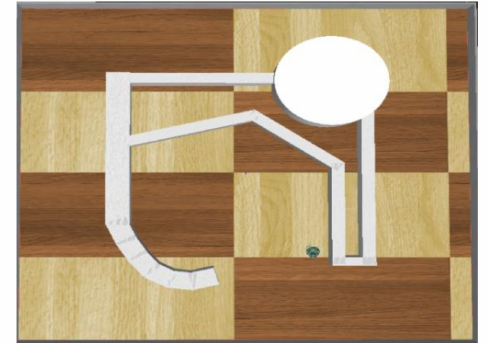
Figure 17. Training setting for wall-following control.